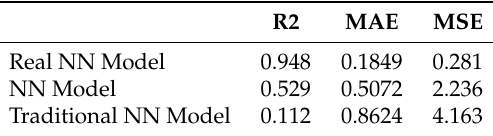
Table 9. Performance